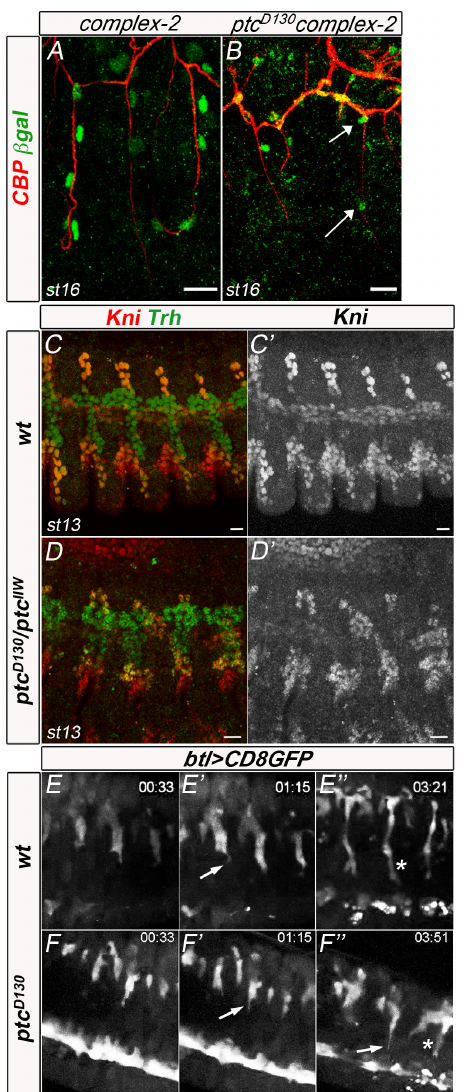
Figure 3. Ptc is not required for GB fate determination and the formation of tracheal cellular extensions. (A,B) Stage 16 wt (A) and ptc mutant (B) embryos carrying the Complex-2-lacZ reporter stained with the chitin binding probe (CBP) to visualise the tracheal lumen and the anti-ßgal antibody to mark all GB nuclei. Arrows indicate Complex-2 positive nuclei. (C–D) Stage 13 wt (C) and ptc mutant (D) embryos stained with anti-kni (red) and anti-trh antibody to mark all tracheal nuclei. C 9 and D 9 are images of the red-channel confocal projection. Kni expression is detected in cells of dorsal, visceral, lateral trunk and ganglionic branches, as well as in cells surrounding the LTa and LTp/GB in wt and mutant embryos. (E–F) Details of the lateral/ ventral side of a live wt (E) and ptc mutant (F) embryo, marked with CD8::GFP driven by btlGAL4 to visualise cytoplasmic extensions during cell migration. Long cytoplasmic extensions are formed by the tip-cells in the wt and mutant GBs. All panels are lateral views. Anterior is left and scale bars are 10 m m in all